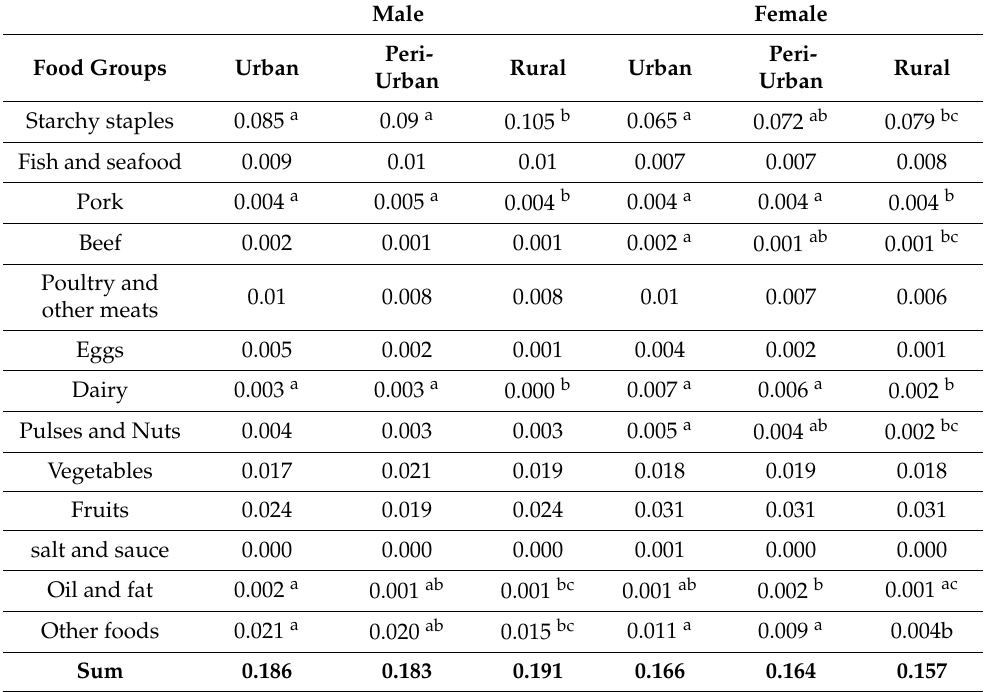
Table A5. Blue water use according to the daily individual daily calorie intake by food group, gender, and districts.